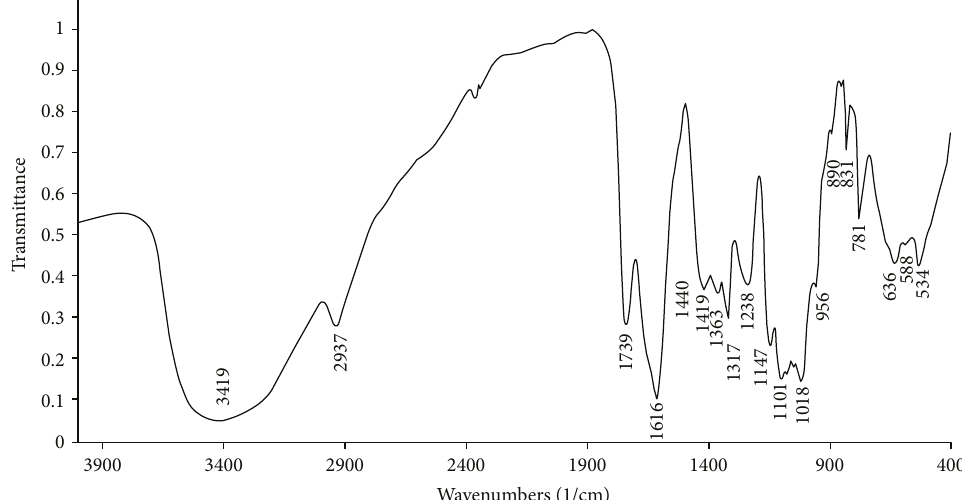
Figure 2: FT-IR spectrum of polysaccharide isolated from in vitro culture of common fumitory. Table 3: Characteristic infrared bands shown by various functional groups.